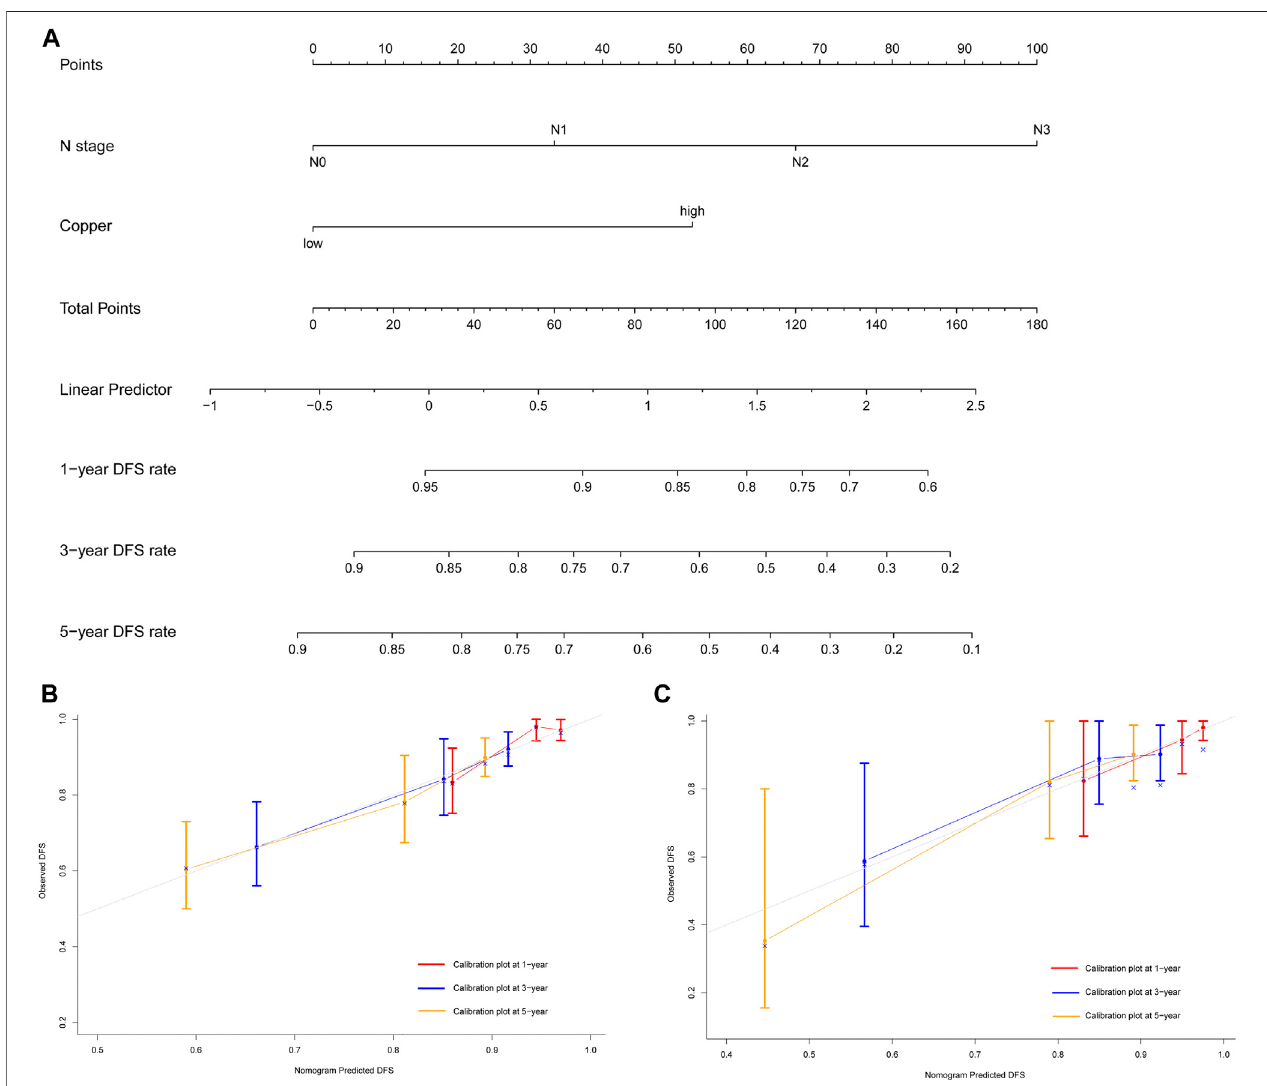
FIGURE5| Developmentandvalidationofprognosticmodelforindividualizedpredictionofdisease-freesurvival(DFS). (A) Nomogramofcurrentprognosticmodel for patientswith early-stage triple-negativebreast cancer. (B) Calibration curves for predicting DFS at 1-, 3-, and 5-years in the training cohort. (C) Calibrationcurvesfor predicting DFS at 1-, 3-, and 5-years in the SYSUCC-001 cohort.